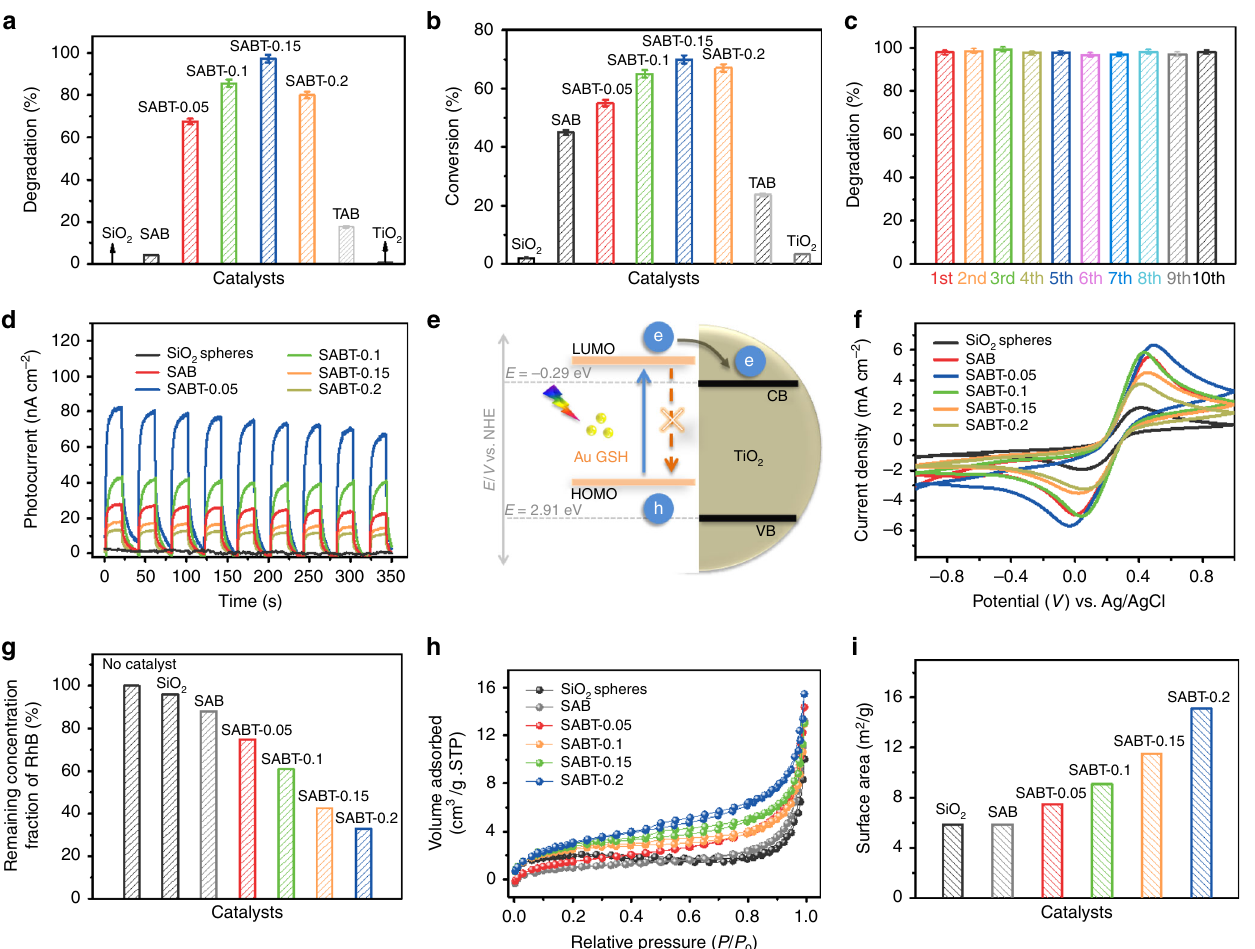
Fig. 3 Photocatalytic activity and the underlying mechanism Photocatalytic degradation of a RhB over blank SiO 2 spheres, TiO 2 , SAB, TAB, and SABT composites with different TiO 2 shell thickness under visible light irradiation ( λ > 420 nm) for 0.5 h; photocatalytic reduction of b p- methoxy nitrobenzene to p -methoxy aniline over blank SiO 2 spheres, TiO 2 , SAB, TAB, and SABT composites with different TiO 2 shell thickness under visible light irradiation for 5 h; c recycling photocatalytic degradation of RhB over optimal SABT-0.15 composite under visible light irradiation ( λ > 420 nm); d transient photocurrent densities of SiO 2 spheres, SAB and SABT composites with different TiO 2 shell thickness under visible light irradiation ( λ > 420 nm); e scheme illustrating the photogenerated electron transport pathways between Au GSH clusters and TiO 2 shell (the blue arrow represents the photoexcitation process of electron – hole pairs; the orange dash line means the recombination of electron-hole pairs; e and h in the blue cycles correspond to the photogenerated electron and hole, respectively); f cyclic voltammograms of SiO 2 spheres, SAB and SABT composites with different TiO 2 shell thickness; g bar plots showing the remaining RhB in reaction solutions after being kept in dark for 3 h to achieve the adsorption – desorption equilibrium over SiO 2 spheres, SAB and SABT composites with different TiO 2 shell thickness; h nitrogen adsorption – desorption isotherms of SiO 2 spheres, SAB and SABT composites with different TiO 2 shell thickness; i surface area of SiO 2 spheres, SAB and SABT composites with different TiO 2 shell thickness. Note that the error